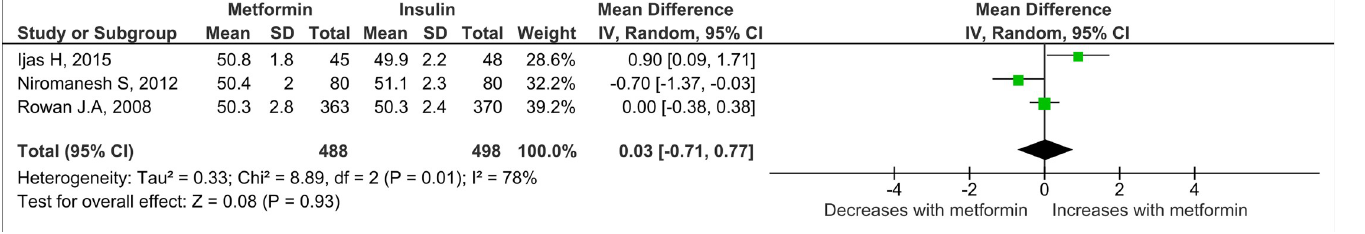
Fig 6. Neonatal height. Expressed as mean difference (random effects model) and 95% CI. IV, mean difference.